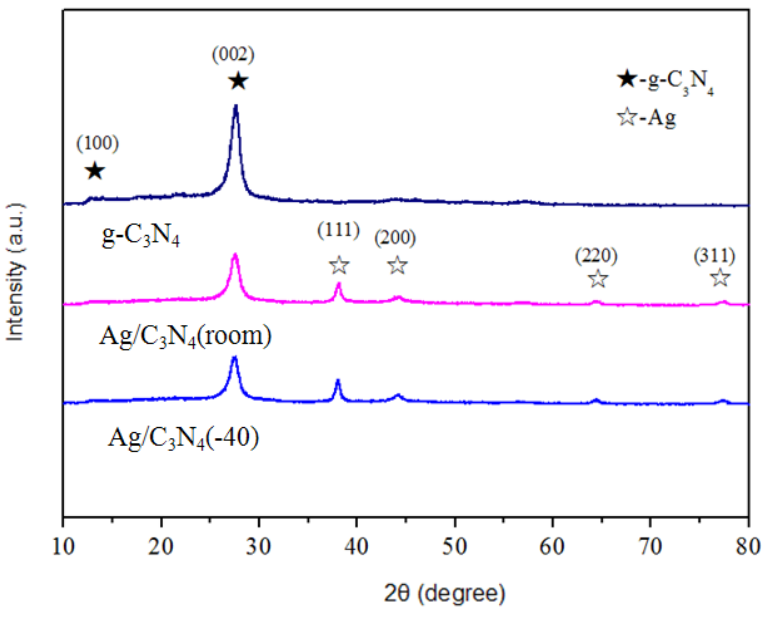
Figure 1. XRD of pure CN, Ag/C 3 N 4 ( − 40) and Ag/C 3 N 4 (room). Additionally, in our recent work, we found that the relation between the interfacial contact area of Ag (NPs)/CN and photocatalytic performance shows a typical volcano curve [15]. Hence, the connection of metal and the support has a significant effect on the transfer of light